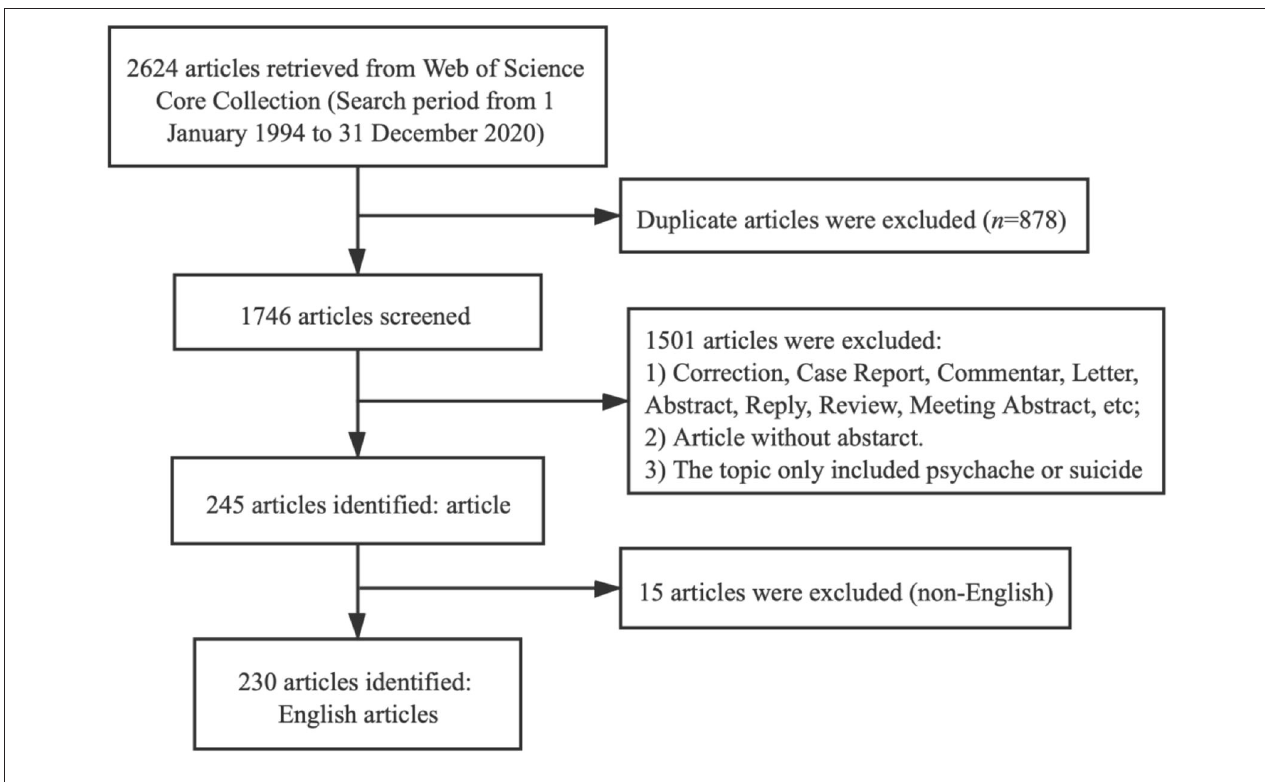
FIGURE 1 | The flowchart of included and excluded studies.